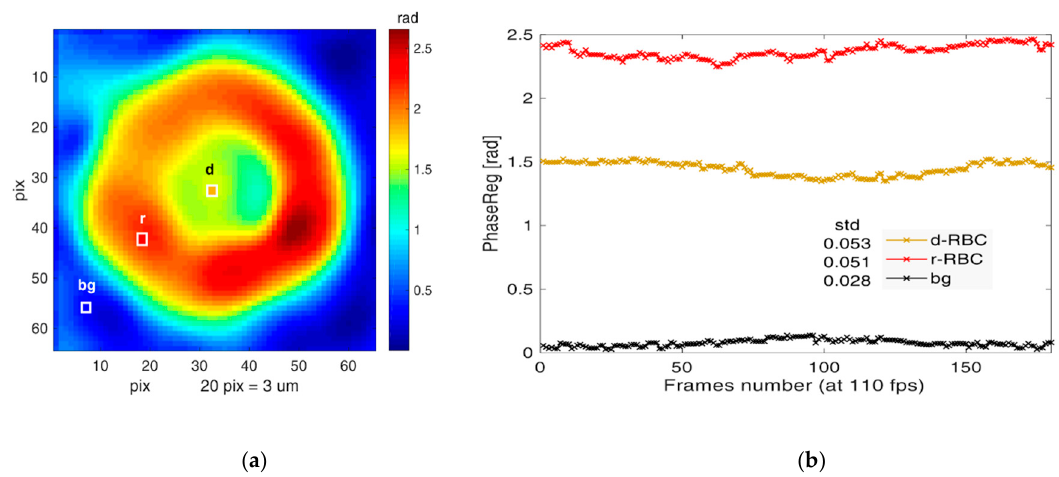
Figure 6. ( a ) Optical phase difference (OPD) over the cell, with three points chosen randomly: ring, dimple, background; ( b ) OPD fluctuations recorded for t > 1 s and standard deviation calculated.